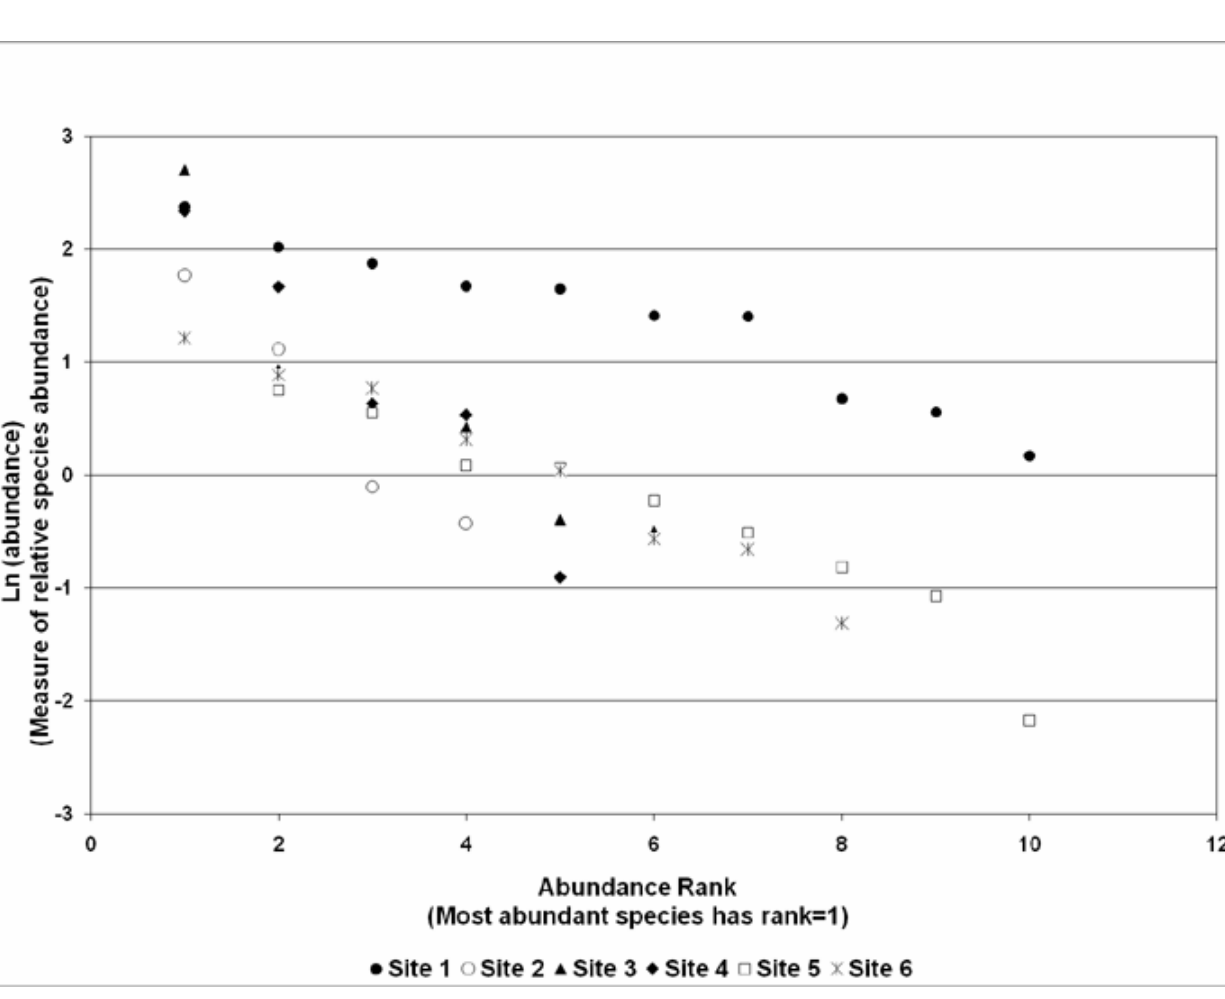
Fig. 4. Plot-scale (dbh>5 cm) dominance-diversity curves in traditional